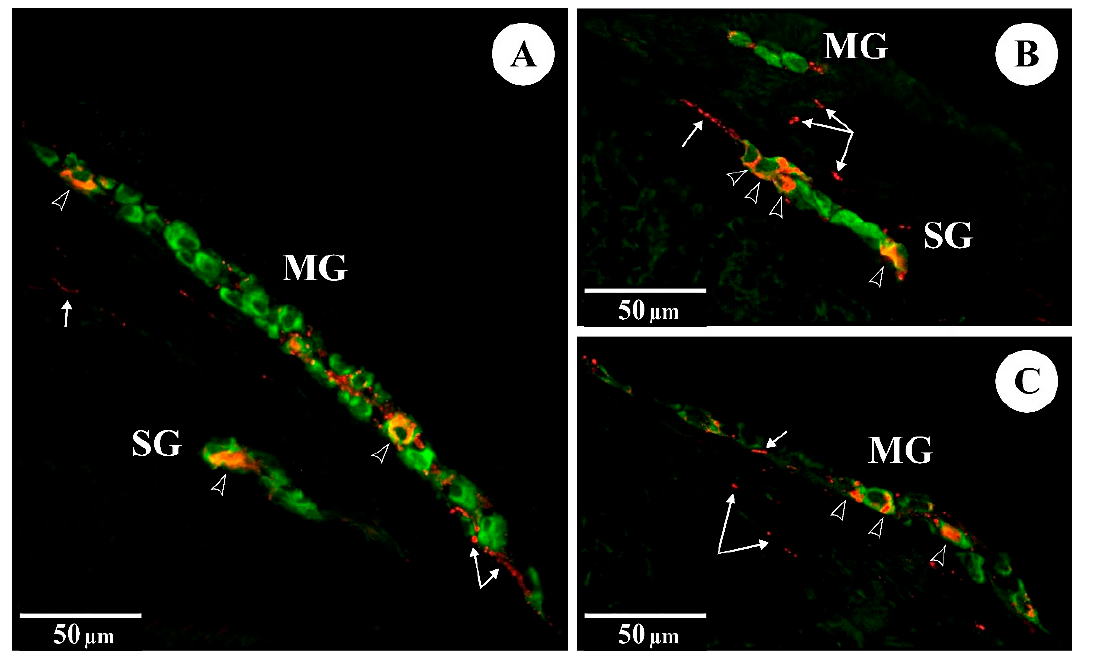
Figure 1. The immunoreactivity of Hu C/D (green) and VIP (red) in myenteric (MG) and submucosal (SG) ganglia of the rat duodenum: ( A ) control group; ( B ) FB 60 group; ( C ) FB 90 group; empty arrowheads indicate Hu C/D-IR/VIP-IR neurons, arrows indicate VIP-IR fibres.